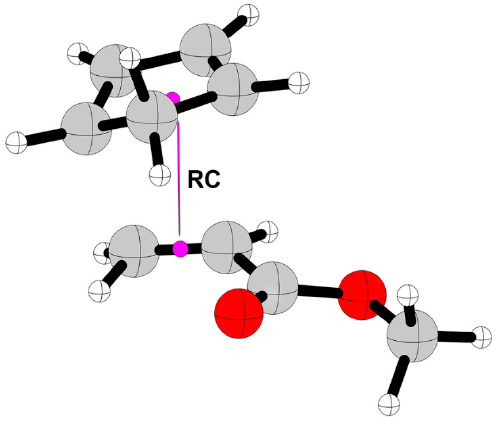
Figure 1. Diels-Alder reaction coordinate (RC) defined as distance between the midpoints of the C = C bond of methyl acrylate and cyclopentadiene’s terminal carbons. The exo-cis transition structure from a gas-phase M06-2X / 6-31G(d) optimization is